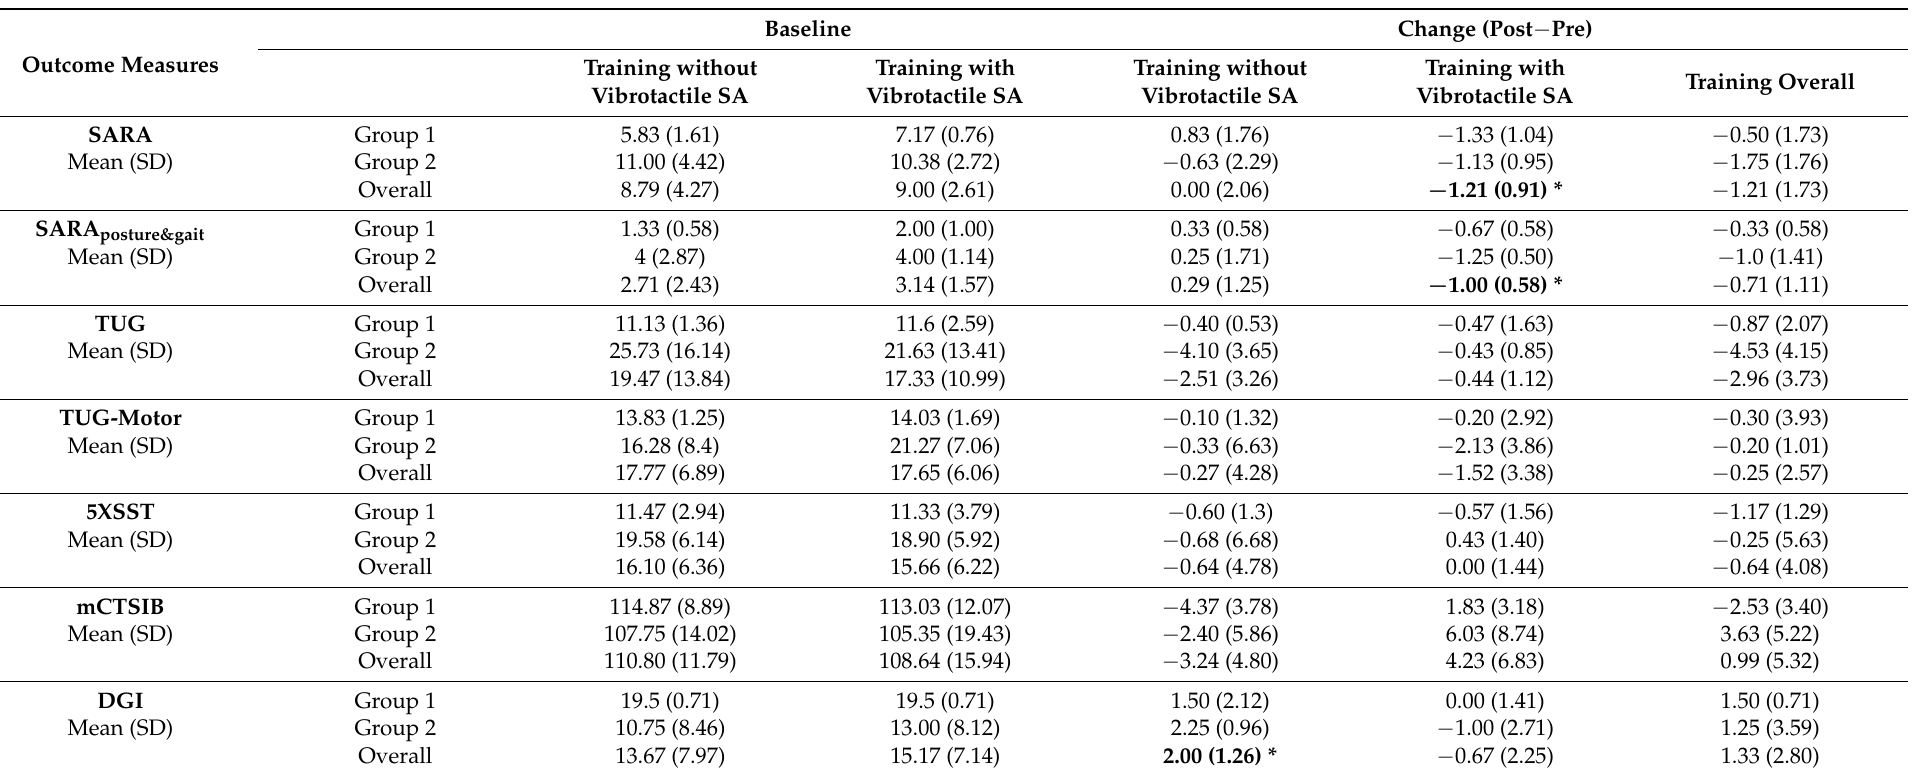
Table 6. Mean (SD: standard deviation) clinical outcome measure scores at baseline and changes observed for each intervention. (*) indicates statistically significant changes ( p <